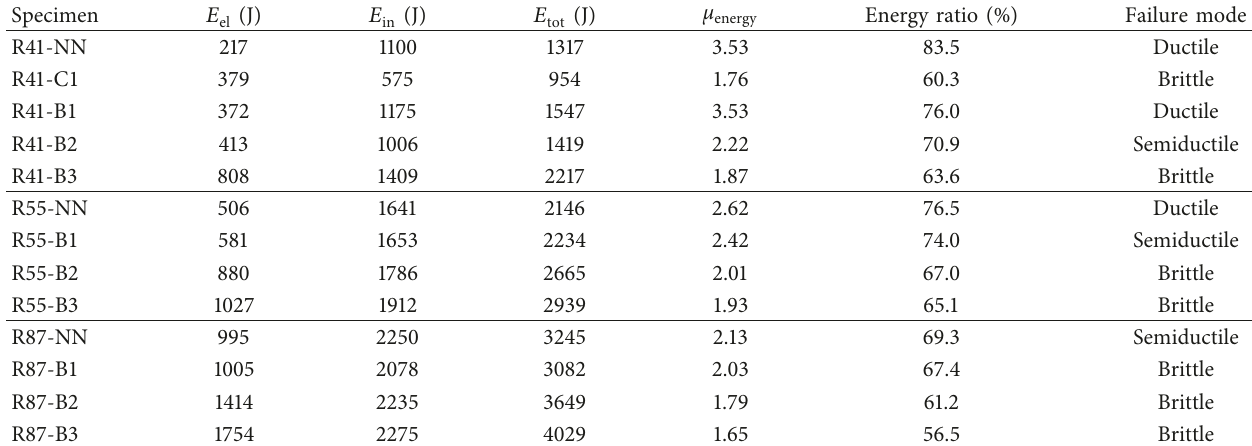
Figure 8: Definition of ductility index Table 6: Results of ductility evaluation.